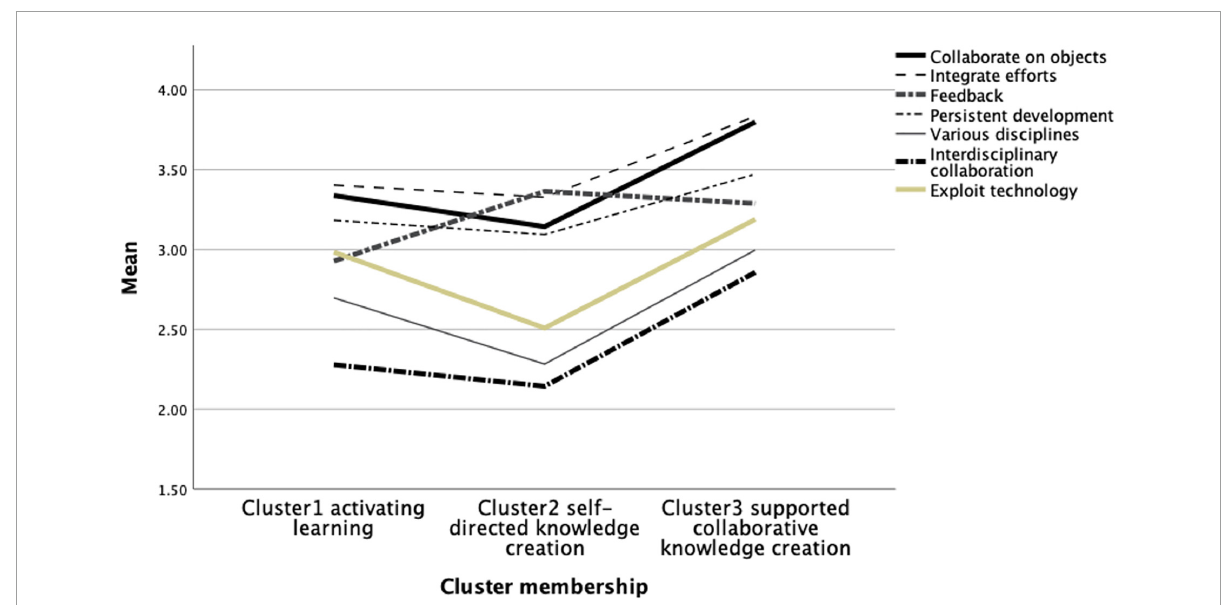
FIGURE3 Learning of knowledge work competences by pedagogical practices.